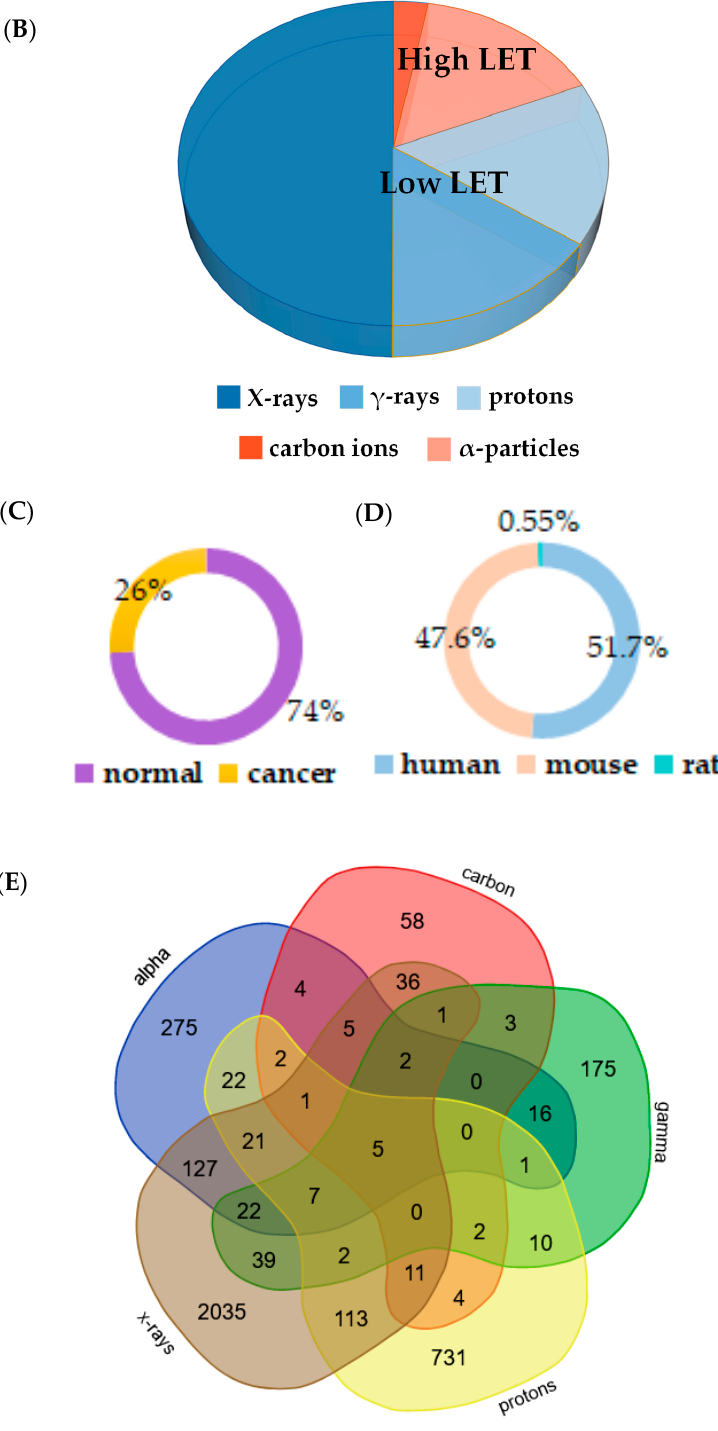
Figure 2. A description of the contents of the database and commonalities among the several radiation types. Database statistics. ( A ) Number of entries corresponding to tissues and cell lines are shown on top of the bars; the height of the bars is proportional to the number of entries. Percentage of entries related to ( B ) radiation types, ( C ) cancer and normal, ( D ) human and rodent tissues/cells across different types of radiation. ( E ) Venn diagram illustrating the overlapping of differentially expressed genes (both up and downregulated) between all radiation groups. The five common genes in all radiation groups are GDF15 , GADD45A , SESN1 , CDKN1A and TP53INP1 .3.3. Each radiation type is linked to distinct biological